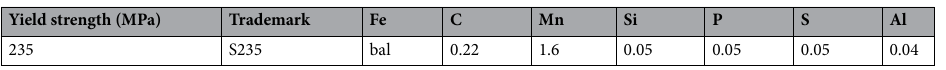
Table 1. Chemical composition of investigated parental steels in wt%.